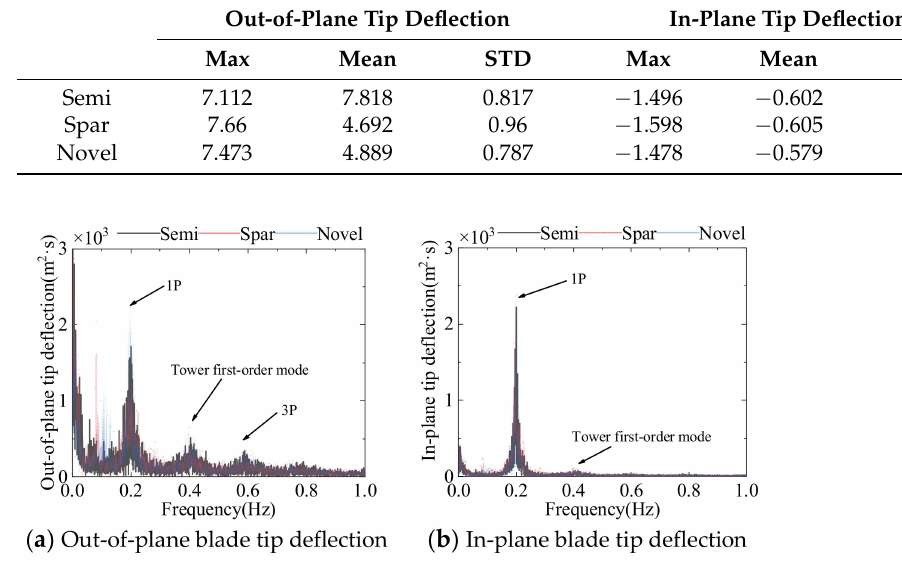
Figure 26. Power spectral density of blade tip deflection of three FOWTs.